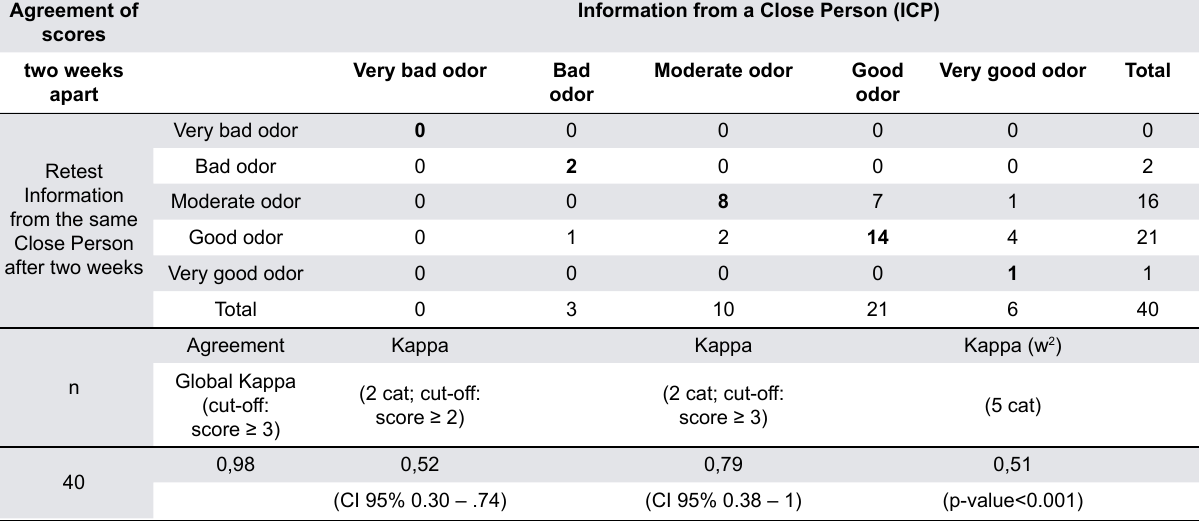
Table 1- Test-retest reproducibility of the presence of halitosis according to the interview with a close person (ICP); patients and companions who attended the digestive endoscopy service at one university hospital, Rio de Janeiro,